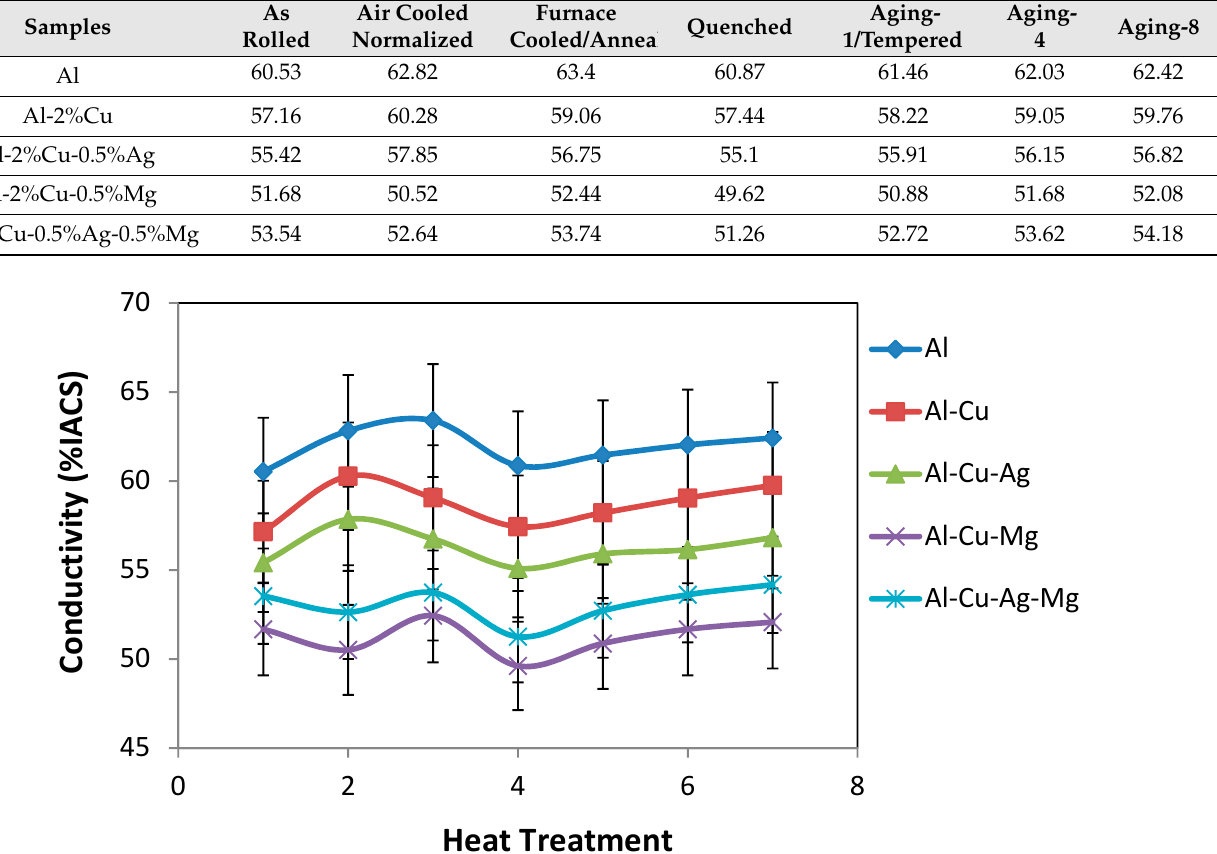
Figure 7. Variation of Conductivity (%IACS) with heat treatment of different alloys.